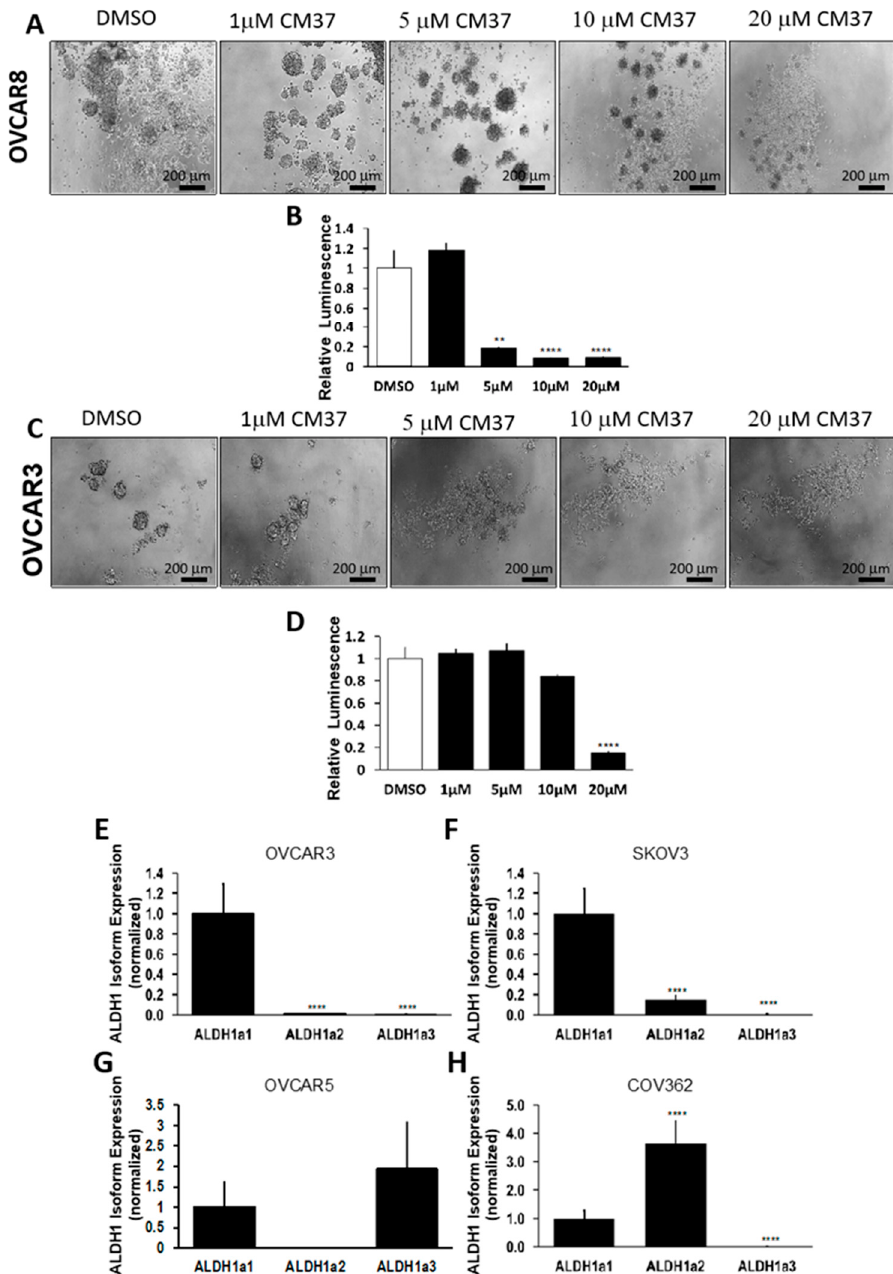
Figure 2. Effects of CM37 on OC sphere formation: CM37 disrupts ALDH1A1-mediated sphere formation and growth under low attachment conditions. ( A , B ) OVCAR8 cells were treated with DMSO or 1–20 µM CM37 for six days, and numbers of live cells were assessed by quantifying ATP production via Cell-Titer Glo assay. Spheres were photographed with an inverted microscope at 100× magnification. ( C , D ) OVCAR3 cells were treated with control or 1–20 µM CM37 for six days, and numbers of live cells were assessed by quantifying ATP production by using the Cell-Titer Glo assay. Spheres were photographed with an inverted microscope at 100× magnification. ( E – H ) Relative expression of ALDH1A isoforms in OVCAR3, SKOV3, OVCAR5, and COV362 cells grown as spheres as measured by qRT-PCR. Bars represent averages of triplicate measurements; ** corresponds to p < 0.01; **** corresponds to p < 0.0001.